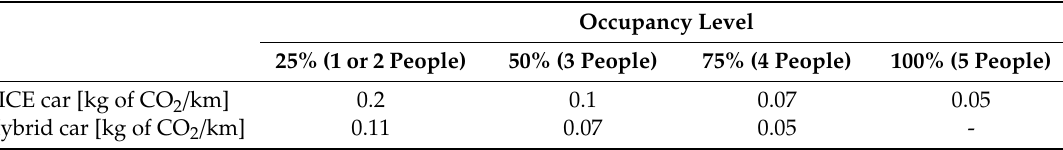
Table 1. CO 2 emissions per kilometre for the internal combustion engine (ICE) car [40] and the hybrid car [41] as a function of occupancy.